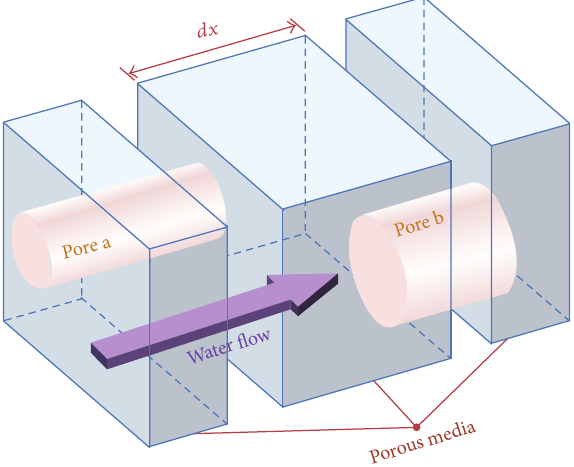
Figure 1: Water flow through concrete.